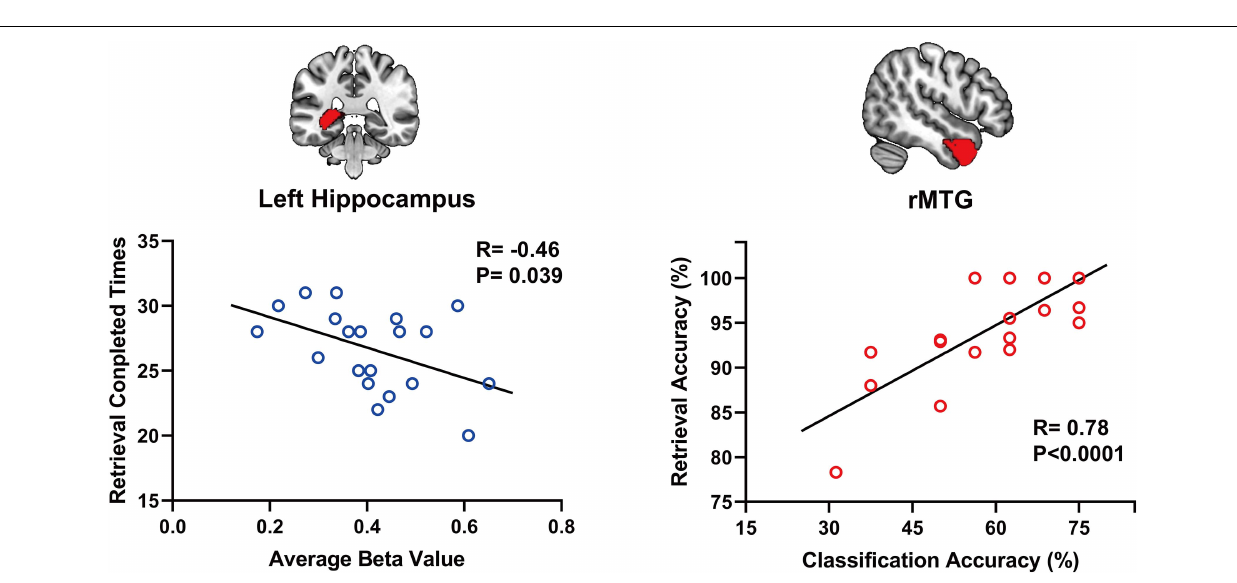
Frontiers in Neural Circuits |